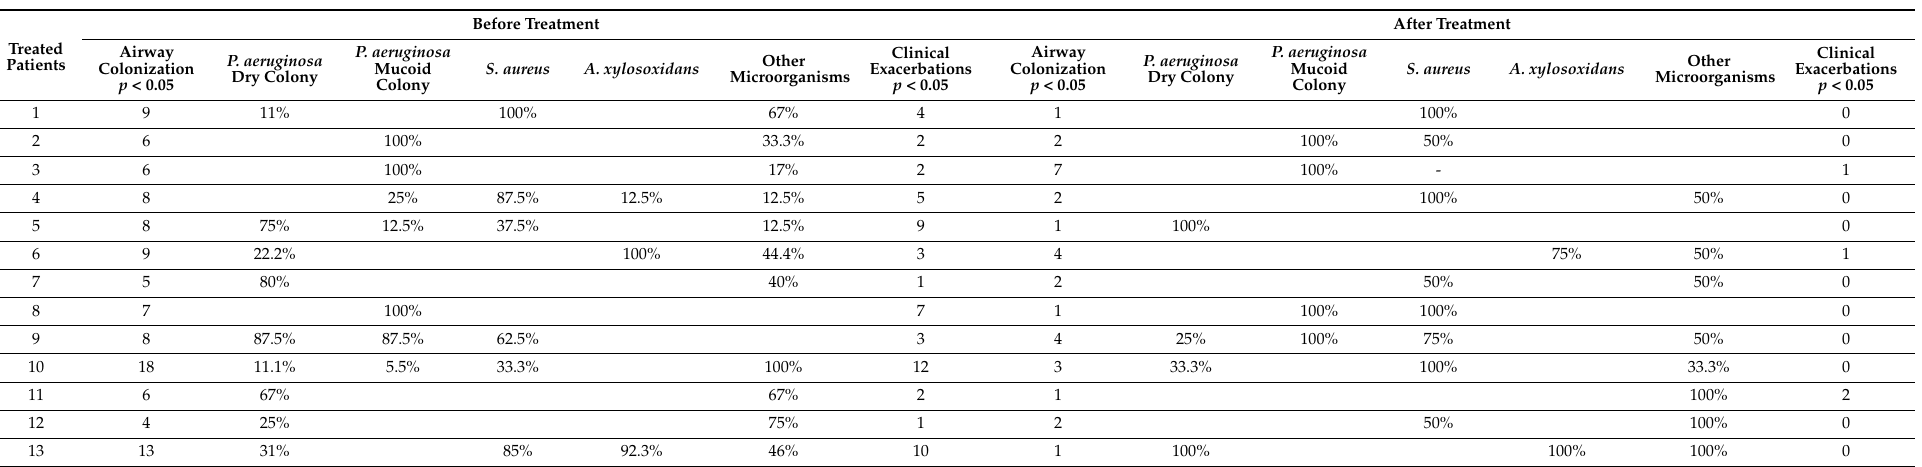
Table 3. Microbial prevalence in case group patients.